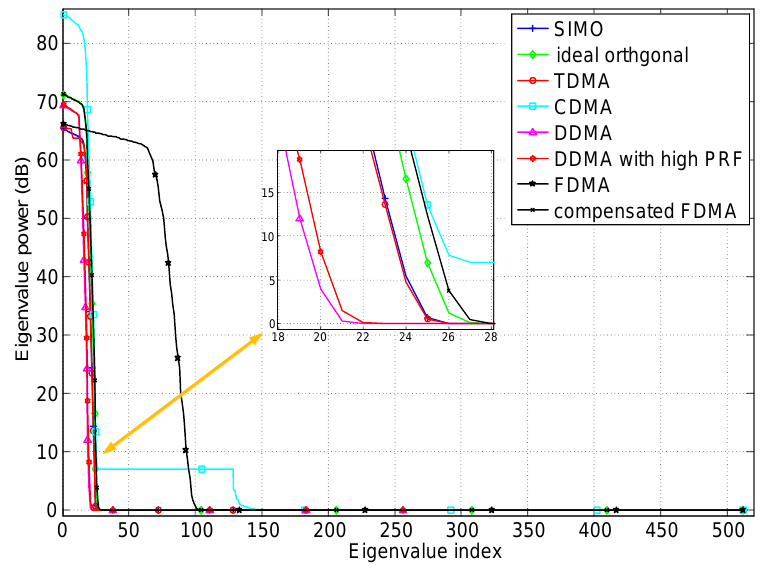
Figure 4. Eigenspectrums of MIMO GMTI radar with different